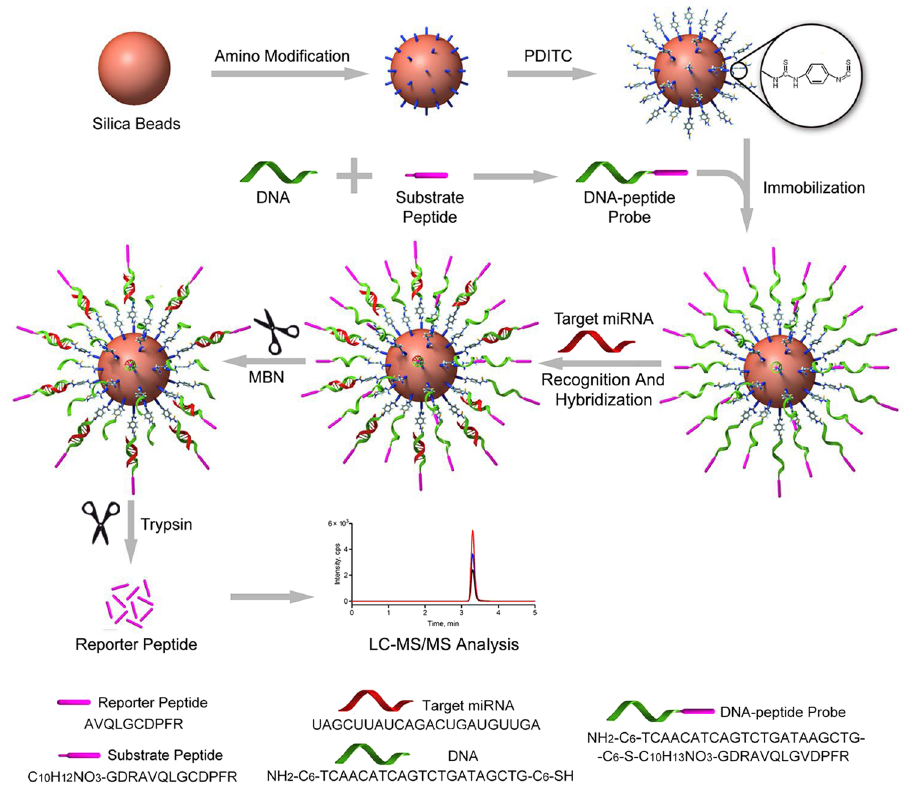
Figure 1. Schematic representation of quasi-direct targeted proteomics approach for miRNA quantification. Substrate peptide containing the sequence of reporter peptide and tryptic cleavage site was tagged to DNA at 3 ′ end, which was complementary to the target miRNA. With PDITC reaction, the DNA-peptide probe